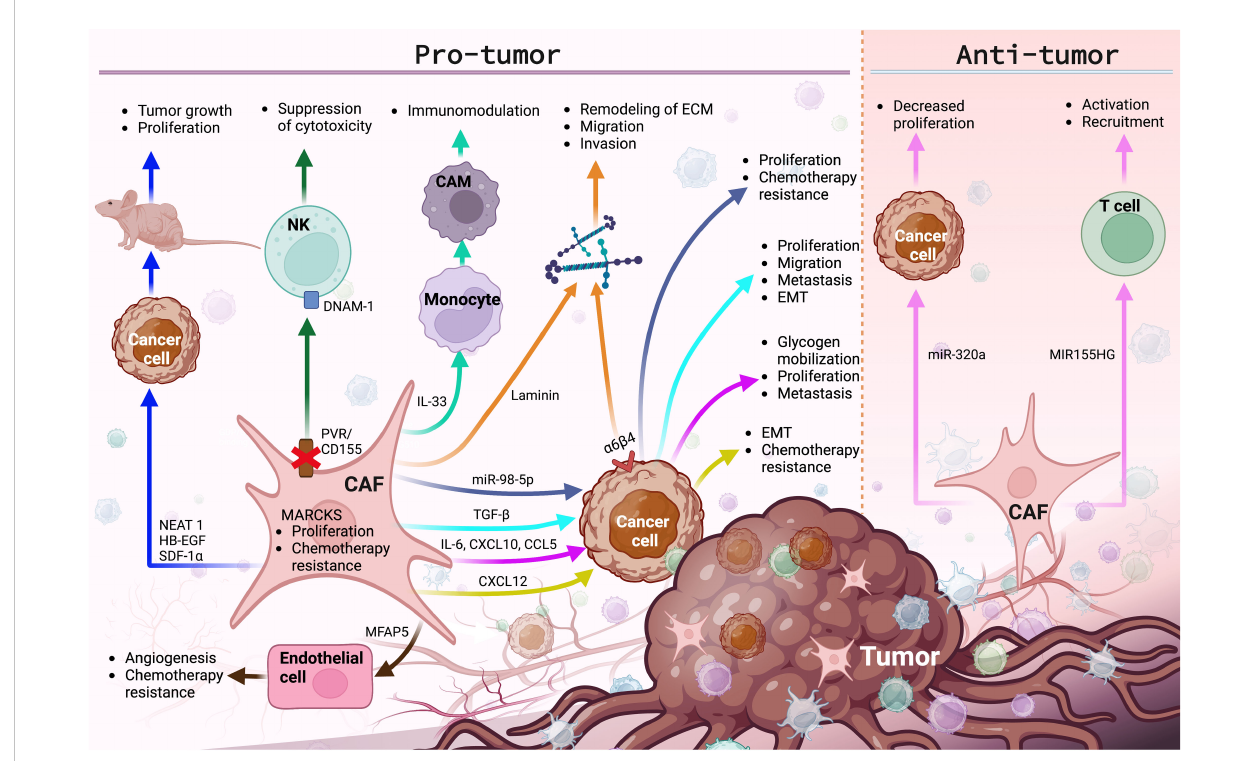
FIGURE 2 The main molecular functions and cellular events exerted by CAFs in the TME of gynecological cancers. CAFs promote various pro-tumor and anti- tumor events, by regulating the expression of membrane receptors and the secretion of growth factors, lncRNAs, miRNAs, interleukins, chemokines and ECM proteins, modulating cancer progression. Image created in BioRender.com and data sourced from (25, 28, 30, 84, 114, 117, 118, 121 – 123, 127, 133, 136, 137, 139, 152, 158 – 163,